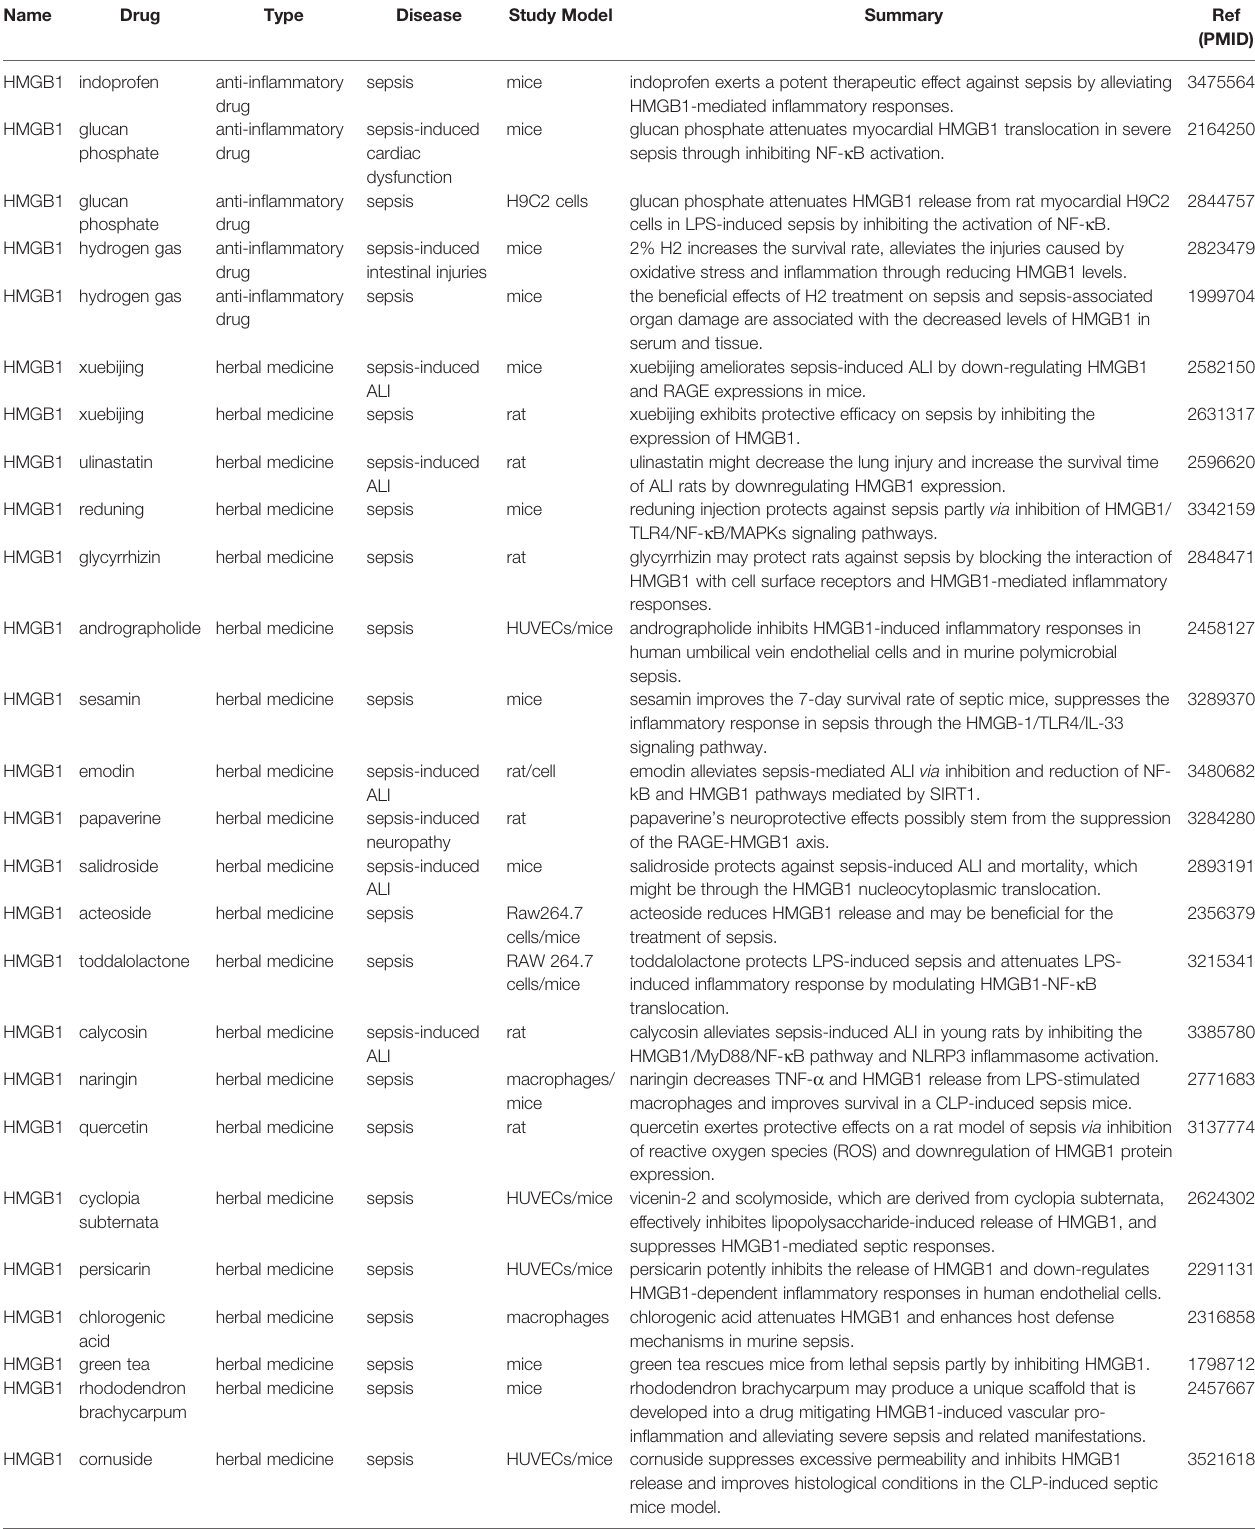
TABLE 2 | Drugs in HMGs and sepsis. Reference given as PMID.